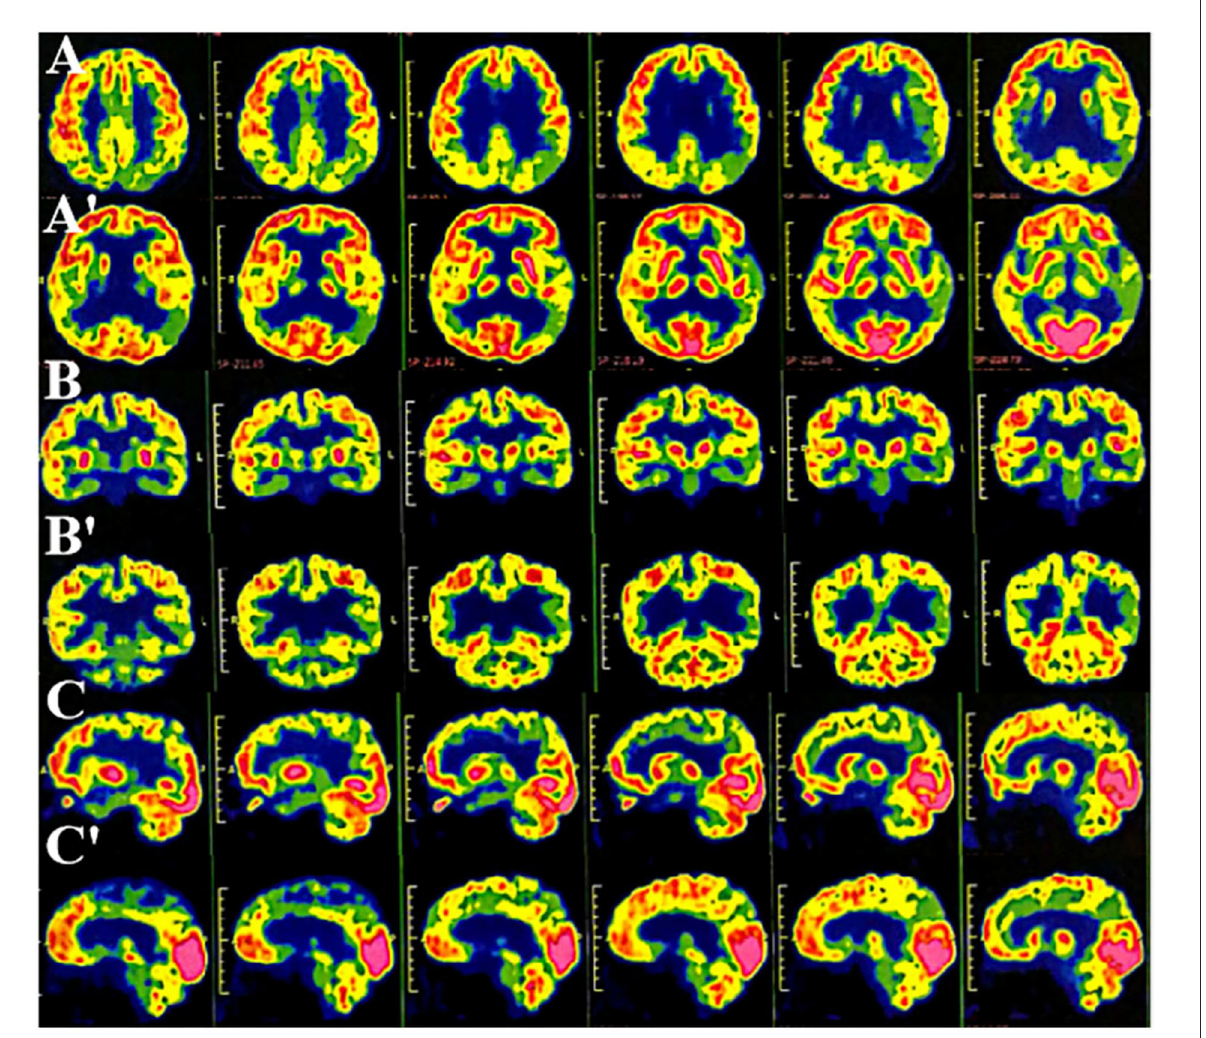
FIGURE2 Multimode molecular imaging of 18-fluoro-2-deoxy-D-glucose positron emission tomography ( 18 F-FDG PET-CT) showed reduced multiple hypometabolism in the bilateral parietal and temporoparietal junction, bilateral temporal lobes (left), and posterior cingulate gyrus ( AA’: cross-sectional sequence; BB’: coronal image; CC’: sagittal